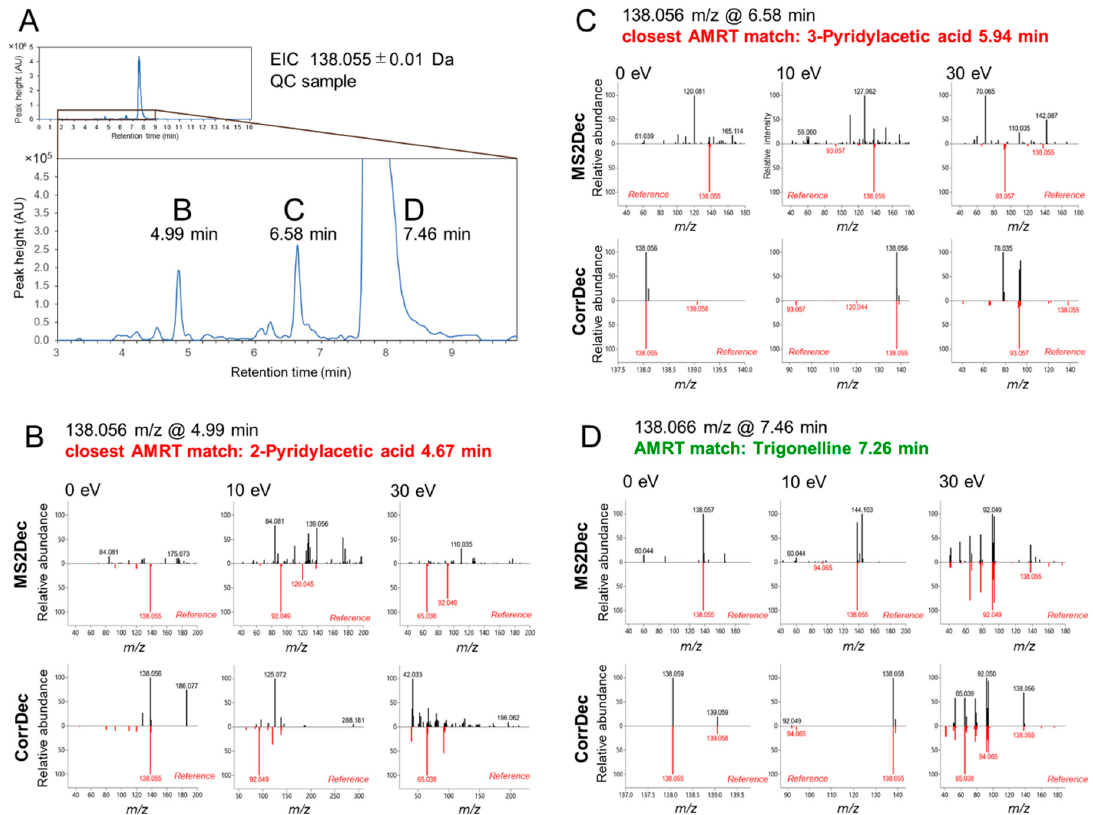
Figure 5. Application of the AMRT + MS2 library to urine metabolomics data acquired in positive ionization mode on a zic-HILIC column. ( A ) Extracted ion chromatogram of m / z 138.055 ± 0.01 Da (corresponding to [C 7 H 7 NO 2 + H] + ) from a quality control (QC) sample. Two peaks at ( B ) 4.99 min and ( C ) 6.58 min have AMRT matches within 0.7 min, but poor MS2 match despite relative high abundance. A peak at 7.46 min ( D ) despite the mass shift due to high abundance could unequivocally be identified as trigonelline based on the AMRT + MS2 match (trigonelline was not spiked into the sample or known a priori to be present in the